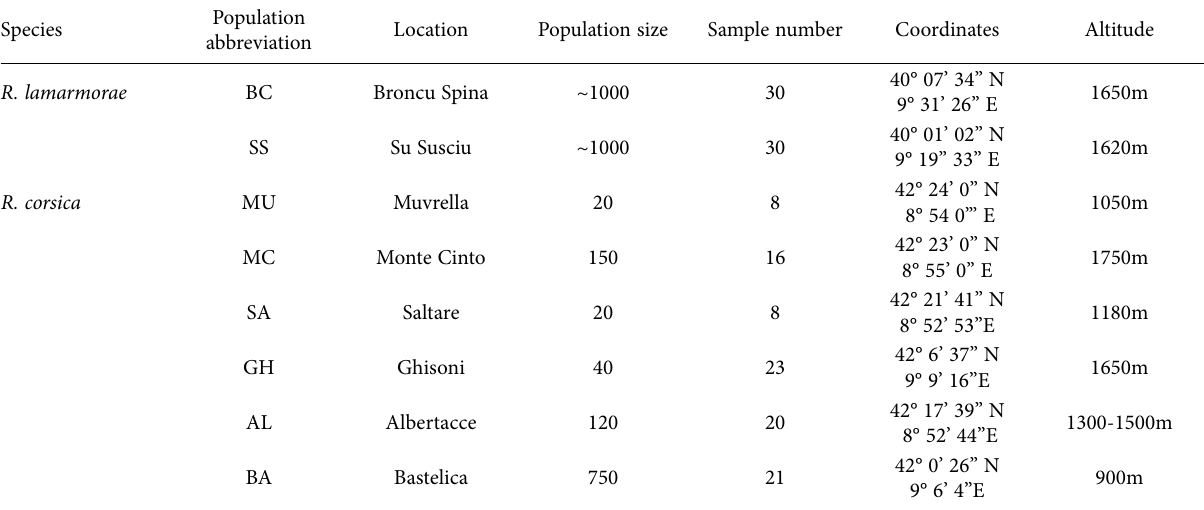
Table 1. Description of populations of R. corsica and sub-populations of R. lamarmorae surveyed in this study.